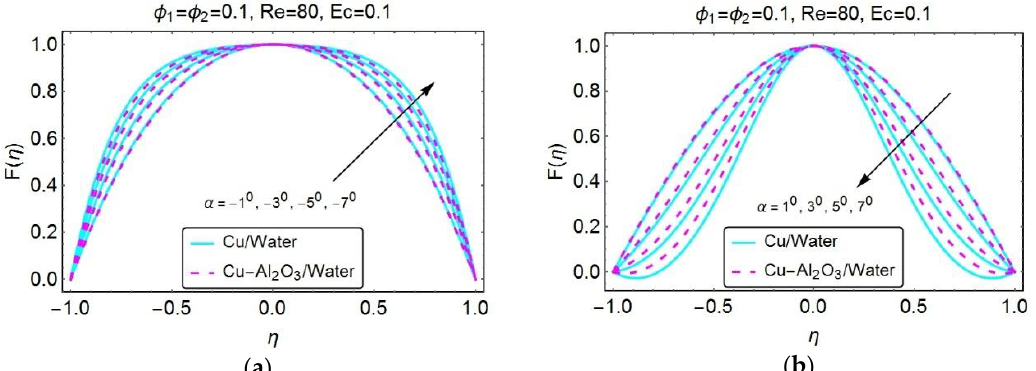
Figure 3. Stimulus of α on F(η) : ( a ) convergent case ( b ) divergent channel.